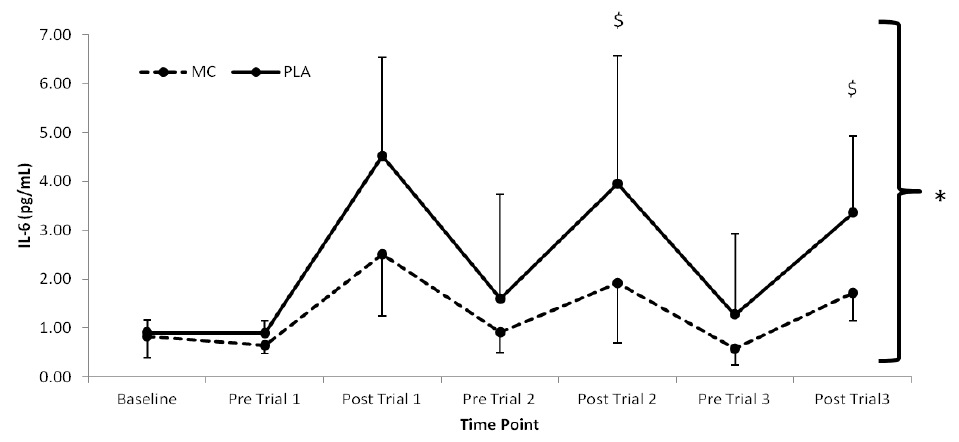
Figure 3. Plasma interleukin-6 responses (pg·mL −1 ) to Montmorency cherry concentrate (MC) and isoenergetic placebo (PLA). * Significant group effect ( p < 0.05), $ Significant